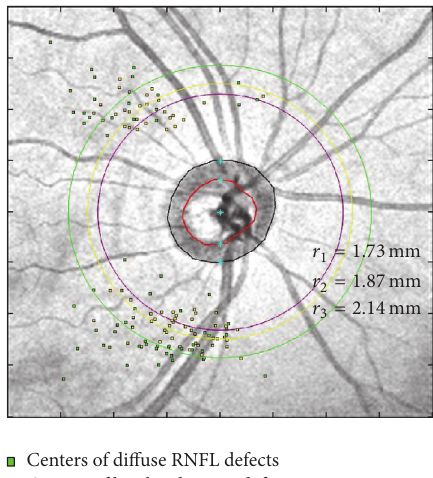
Figure 2: The distribution of centers of localized (green dots) and diffuse (yellow dots) RNFL defects. The average location of diffuse RNFL defects ( 𝑟 2 ; yellow circle) was significantly closer to the center of the optic disc than that of localized RNFL defect ( 𝑟 3 ; green circle). The purple circle was the original scanning position with radius of 1.73